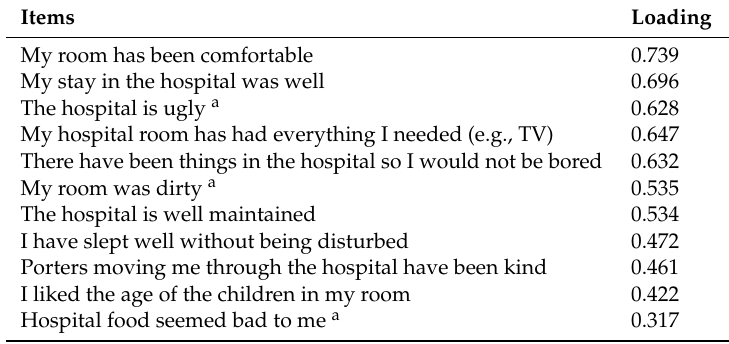
Table 3. Items included in the unidimensional scale ordered by factor